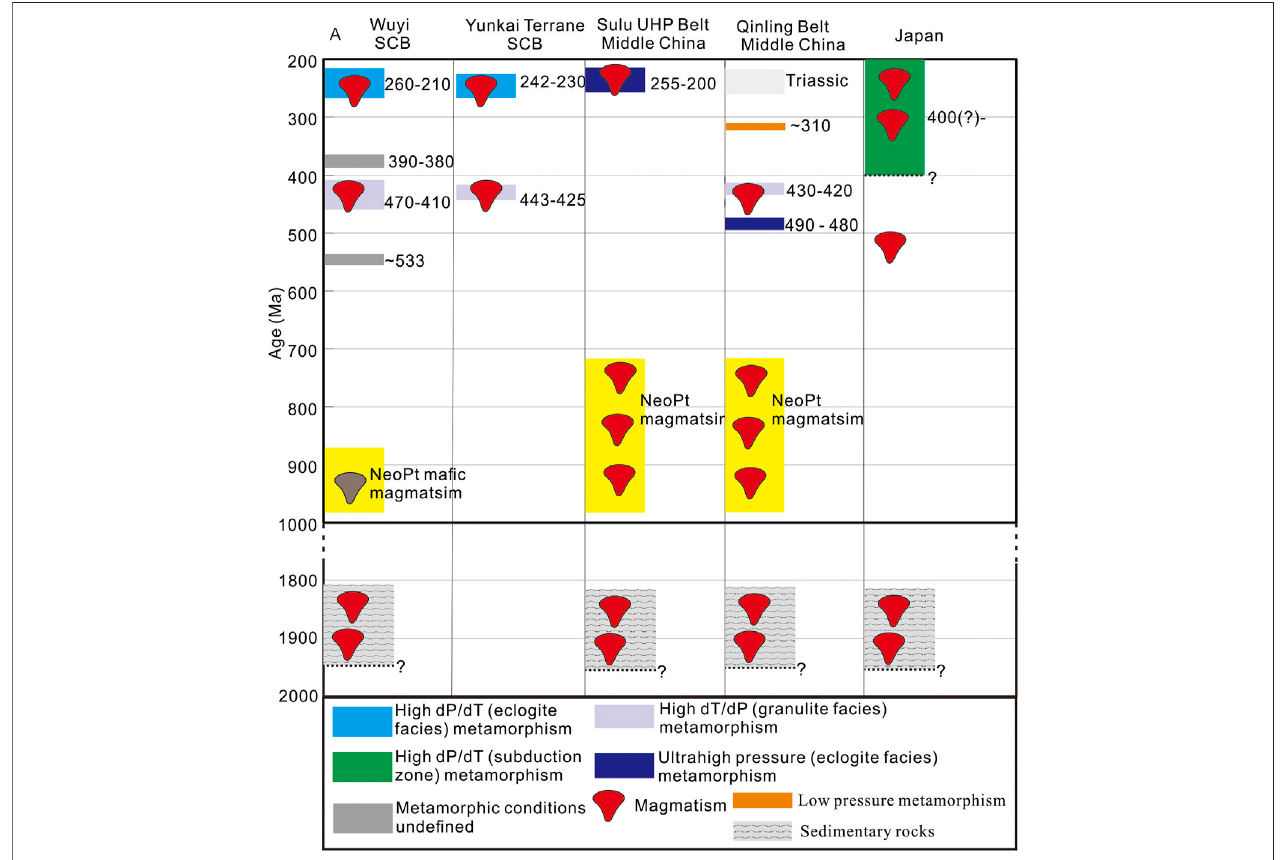
FIGURE 7 | A summarization and comparison of major magmatic, metamorphic and early Precambrian basement rocks in different parts of the orogenic belts in and around the SCB. Related references can be found in the main text.